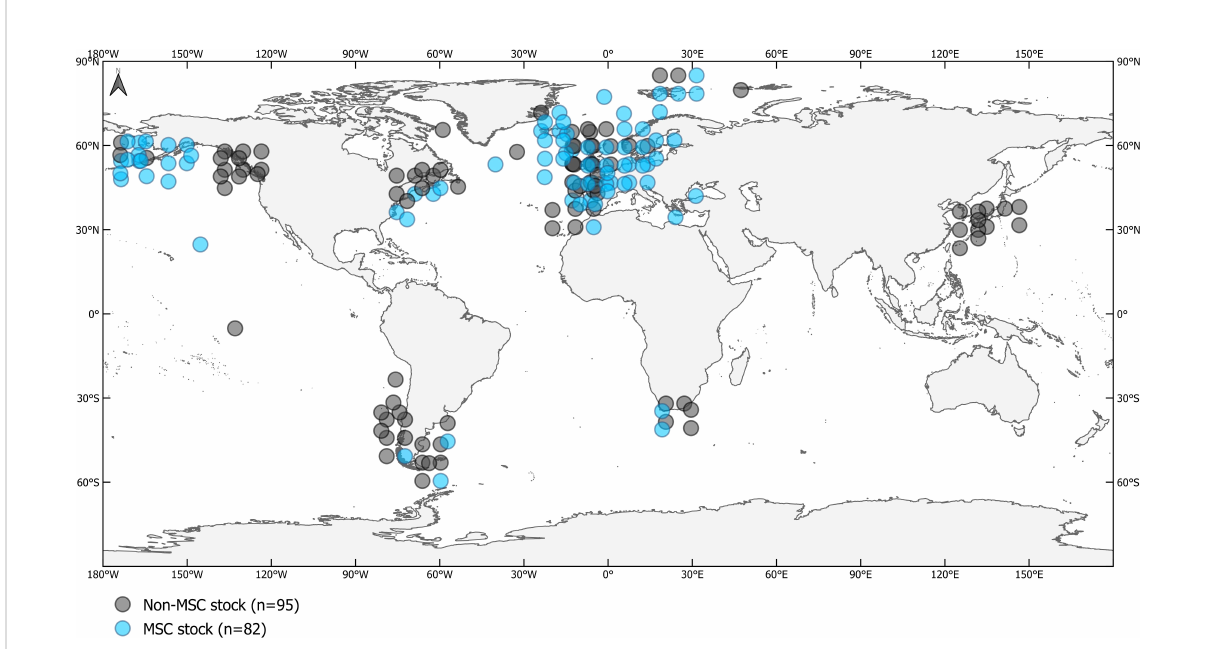
FIGURE 2 Geographic coverage of MSC stocks (n = 82) and non-MSC stocks (n = 95) included in analyses. Data points show approximate centroids of stock distribution areas (most from Free et al., 2019), jittered to reduce visual